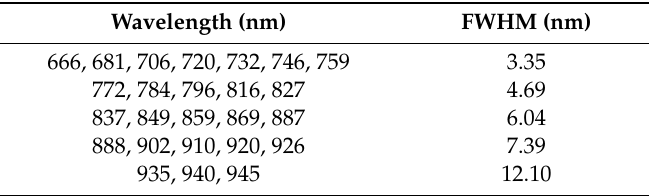
Figure 2. Spectral sensor and the control software of detection system. ( a ) Spectral sensor; ( b ) Control software interface. Table 1. The FWHM values of di ff erent